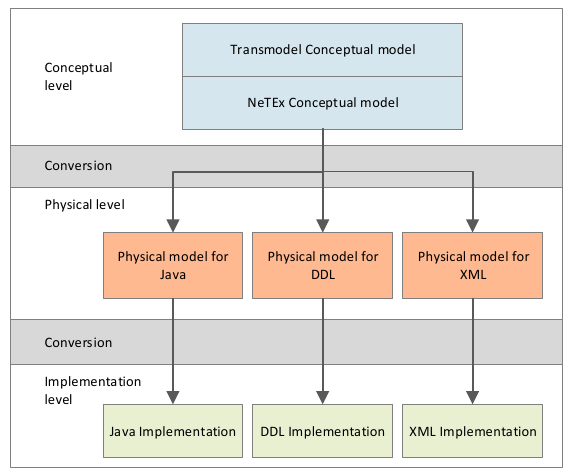
Figure 4. The Model-Driven design in NeTEx. Adapted from (CEN/TC 278, 2014).